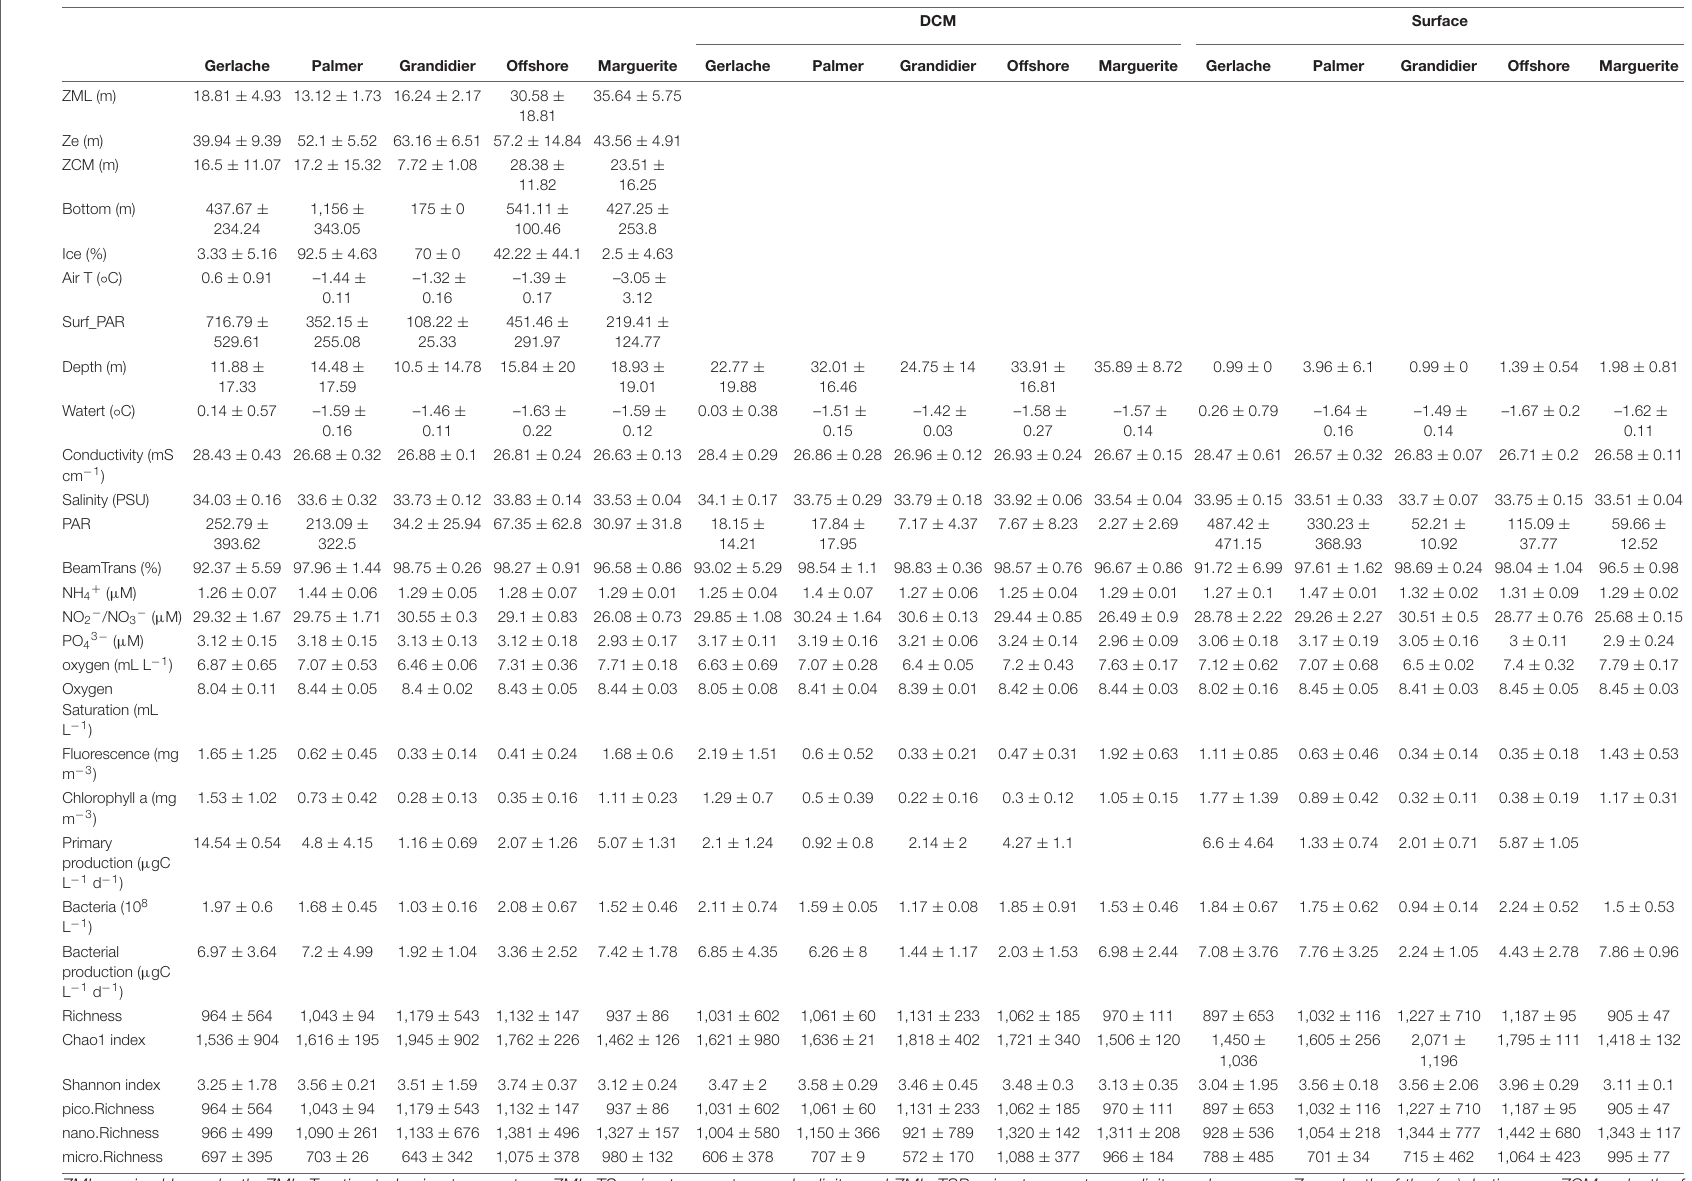
TABLE 1 | Mean (standard deviation) of environmental parameters observed during the austral spring 2019 in different regions of the WAP.